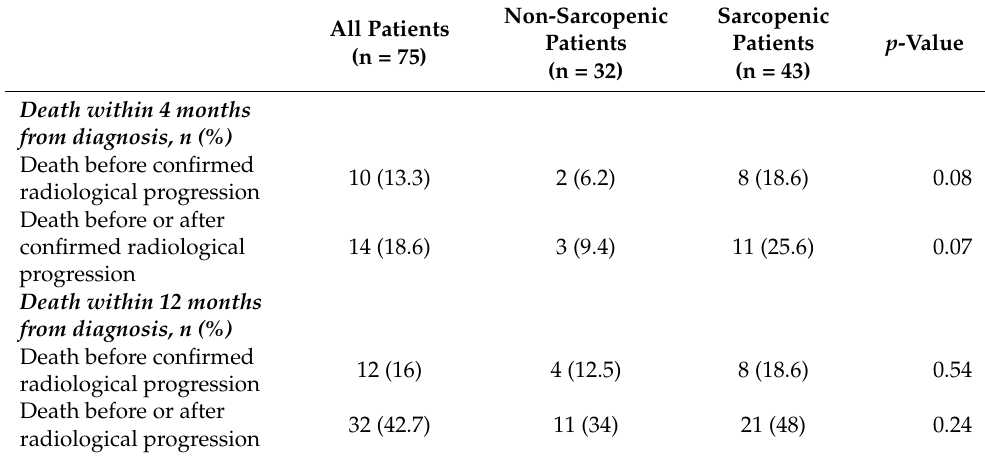
Table 4. Early death in patients receiving FOLFIRINOX for metastatic pancreatic carcinoma.